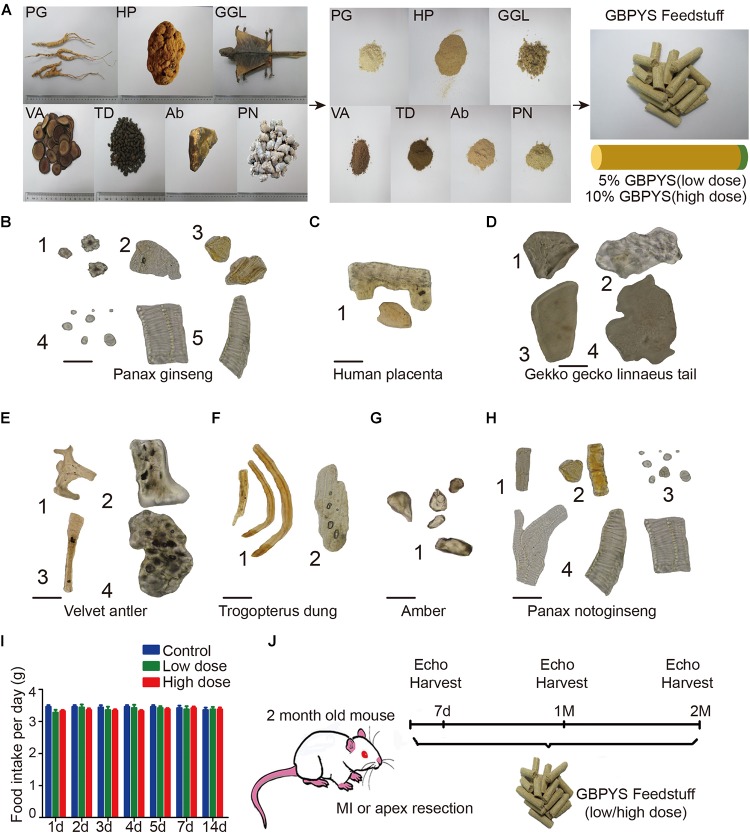
Quality evaluation of the seven components of Gu Ben Pei Yuan San (GBPYS) and diagram of the experimental plan. (A) Each component of GBPYS was powdered and mixed well with regular mouse food. Food containing 5% GBPYS powder is defined as low dose and 10% as high dose. PG, Panax ginseng; HP, human placenta; GGL, Gekko gecko Linnaeus (tail was used); VA, velvet antler; TD, Trogopterus dung; Ab, amber; PN, Panax notoginseng. (B–H) Microscopic identification of each GBPYS component according to published standards in the Chinese Pharmacopoeia. (B) The powder of ginseng. (1) Cluster crystal; (2) cork cell; (3) resin canal; (4) starch granules; (5) vessels. (C) The powder of human placenta. (1) Fragments. (D) The powder of Gekko gecko Linnaeus tail. (1) Bone fragments; (2) skin pieces; (3) striated muscle pieces; (4) flake pieces. (E) The powder of velvet antler. (1) Cuticula; (2) bone chips; (3) pile; (4) non-ossifying tissue pieces. (F) The powder of Trogopterus dung. (1) Fiber; (2) thinner wall cells. (G) Amber. (1) Resins. (H) The powder of Panax notoginseng. (1) Cork cell; (2) resin canal; (3) starch granules; (4) vessels. (I) Average everyday diet amount of regular feed, low-dose GBPYS feed, and high-dose GBPYS feed for mice. (J) Diagram of experimental plan. Echocardiography was used to detect cardiac function at each time point. MI, myocardial infarction; echo, echocardiography. Scale bars, 50 μm.